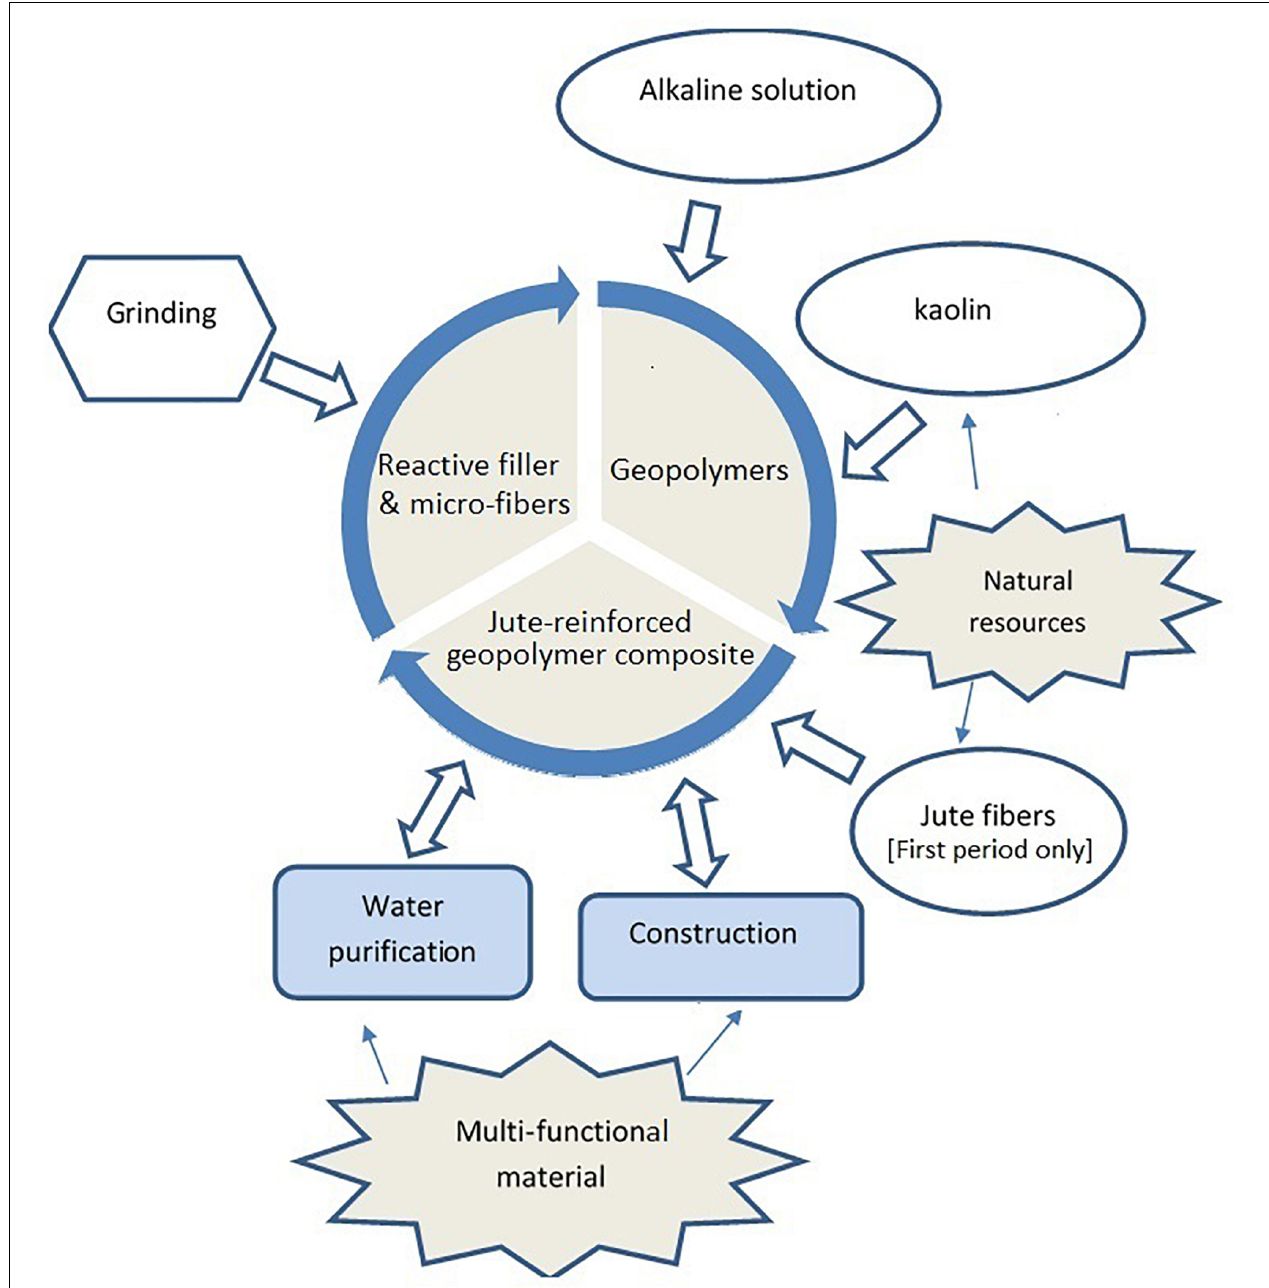
FIGURE 13 | Life-cycle engineering of jute-reinforced geopolymer composite.